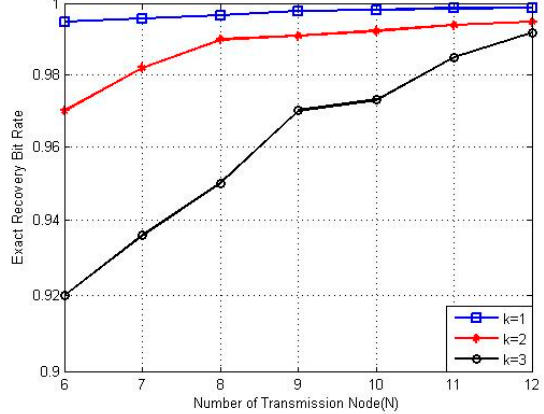
Figure 5. Recovery performance with transmission node (N).